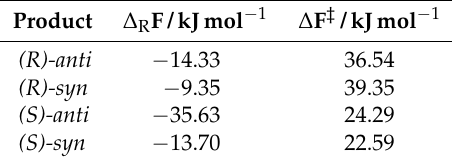
Table 5. Total reaction free energies ∆ R F and reaction free energy barriers ∆ F ‡ for the aldol reactions (R=iPr) in DMF from HyAIMD metadynamics; extracted from Figure 11. Free energies are given relative to